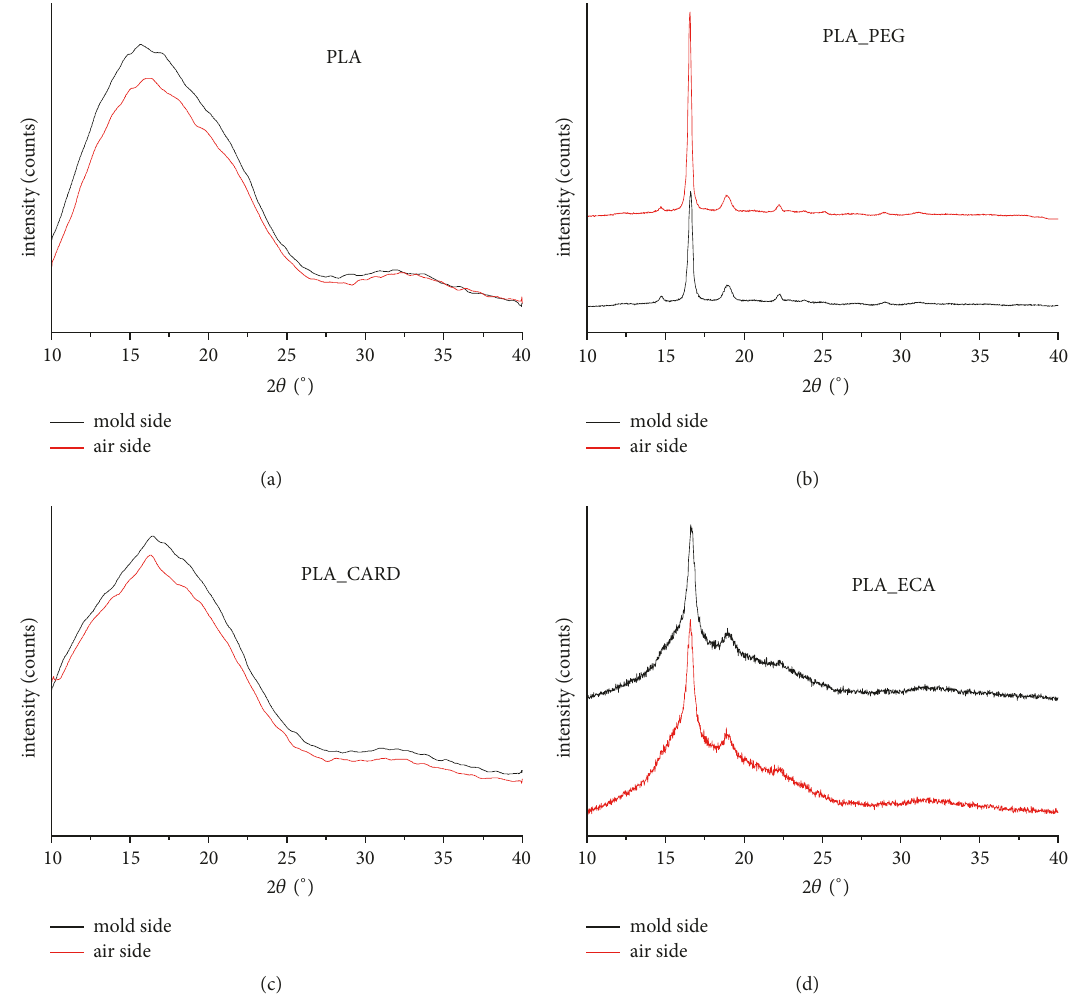
Figure 4: XRD diffraction patterns obtained on rotational molded PLA samples: (a) neat PLA, (b) PEG plasticized PLA, (c) cardanol plasticized PLA, and (d) epoxidized cardanol acetate plasticized PLA.